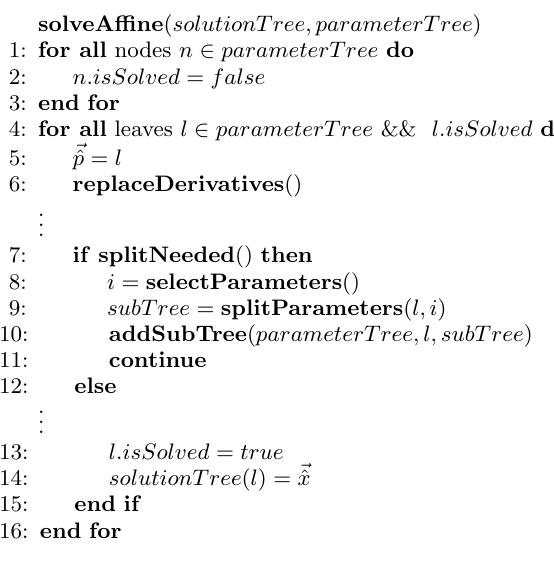
Figure 6: Affine solving algorithm using trees to store results and